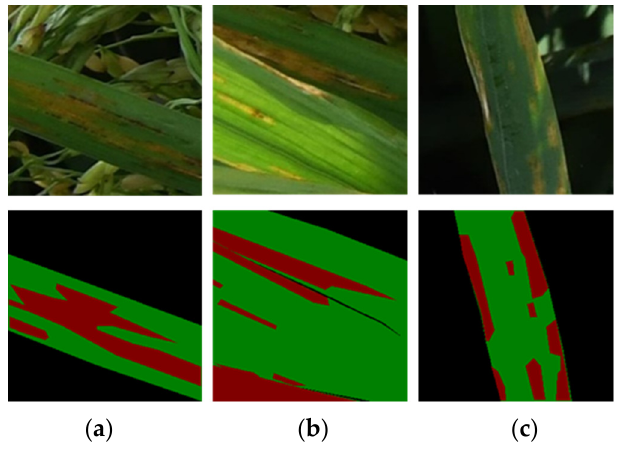
Figure 2. Image types and their corresponding labels, ( a ), ( b ) and ( c ), give three examples of the samples used for training and validation (red, green, and black stand for BLS lesion, leaves, background, respectively).